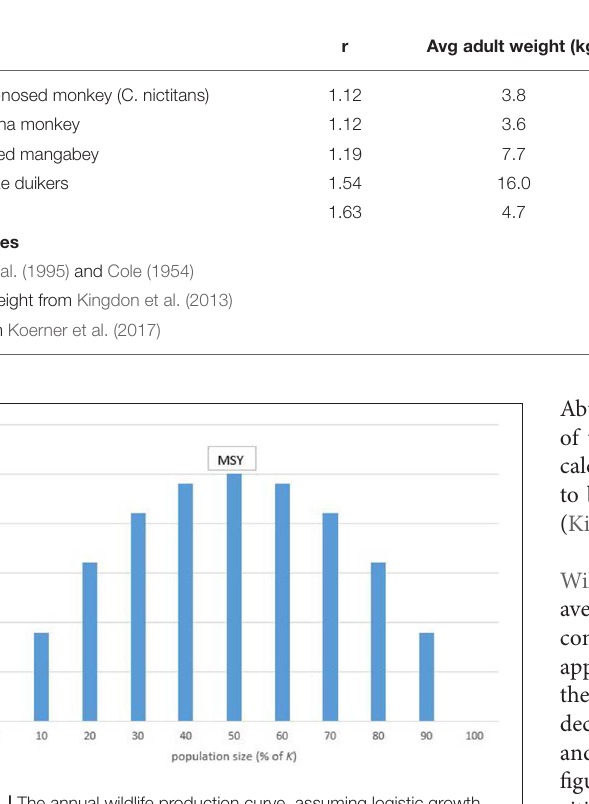
FIGURE 1 | The annual wildlife production curve, assuming logistic growth, follows an inverted U shape with production maximized at 0.5 K.